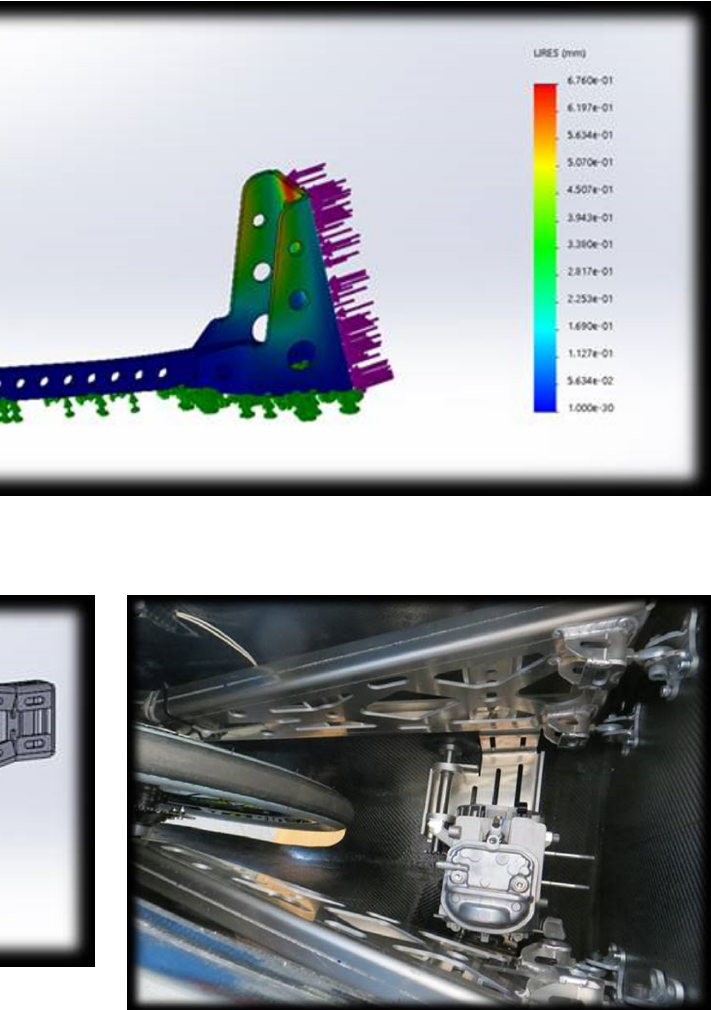
Figure 10: Engine